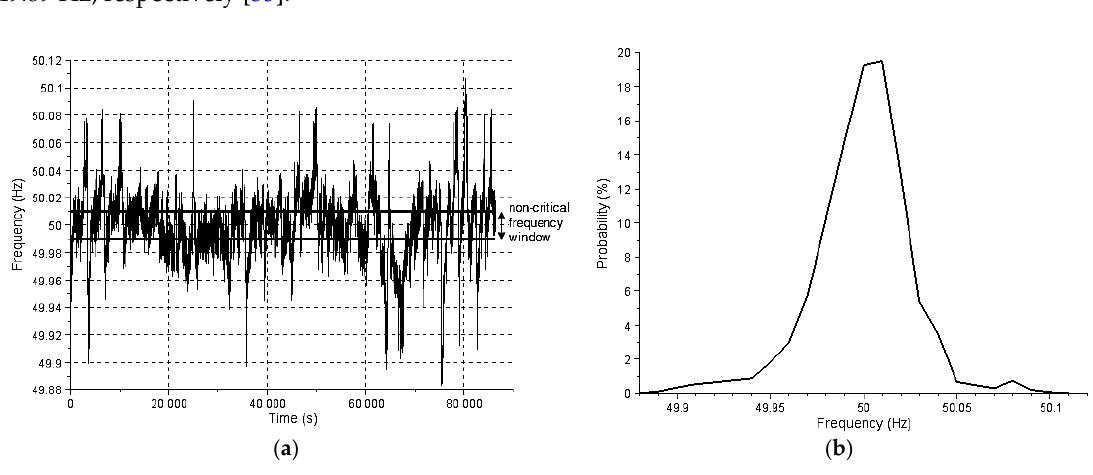
Figure 3. Italian (ENTSO-E) frequency profile measured by Terna and used in PFC tests: ( a ) frequency vs. time during one day; and ( b ) probability distribution of the whole yearly power frequency recording.